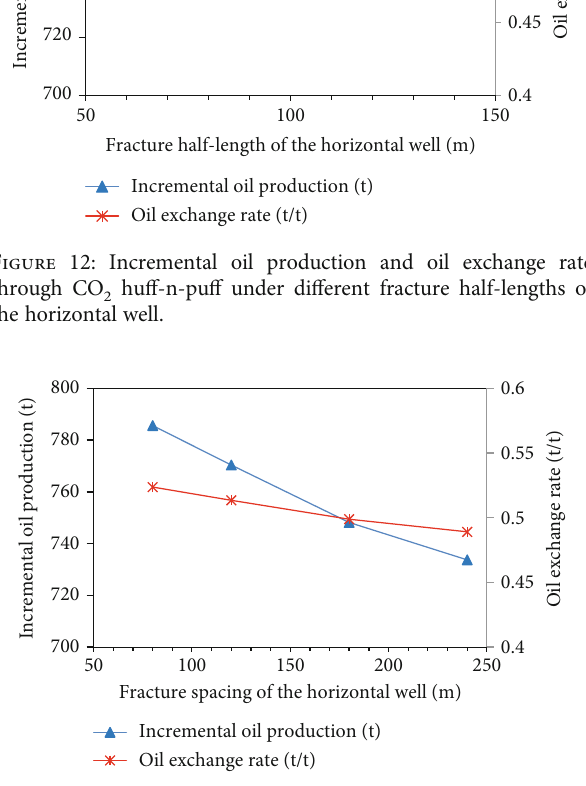
Figure 13: Incremental oil production and oil exchange rate through CO hu ff -n-pu ff under di ff erent fracture spacing along 2 the horizontal wellbore.